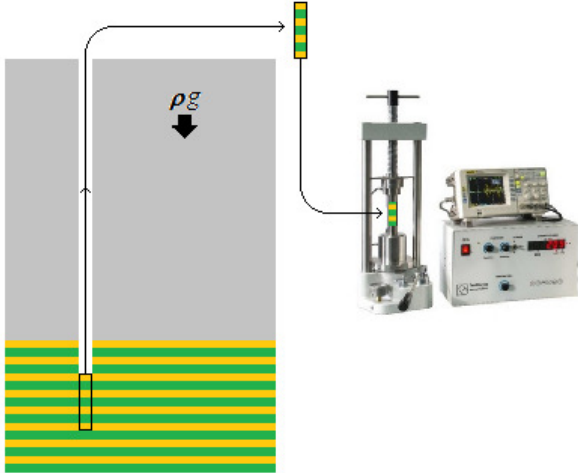
Figure 6. Extraction of a core sample from a stressed massif for